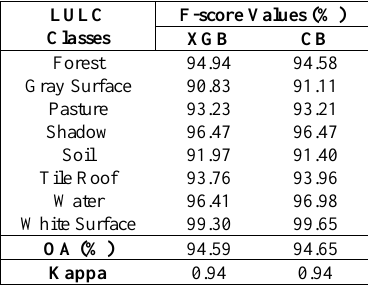
Table 5. Accuracy results of maps produced by pixel-based classification